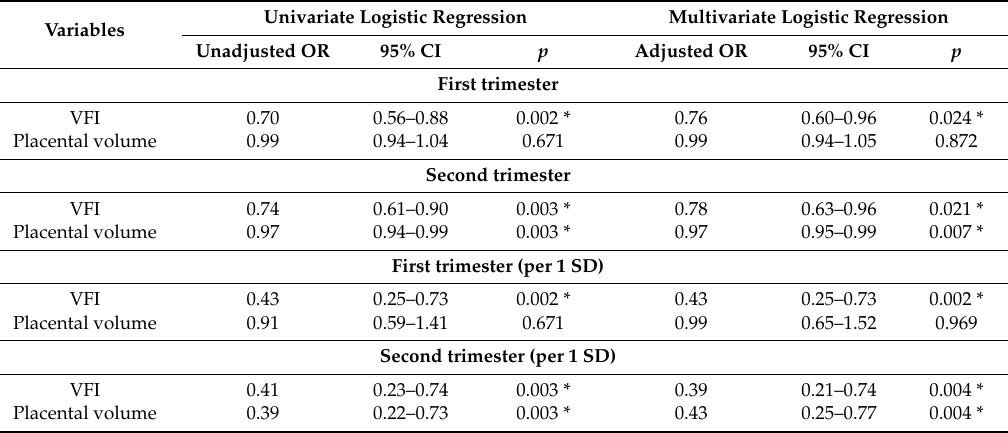
Table 4. Univariate and multivariate logistic regression analyses of the VFI and placental volume. Variables